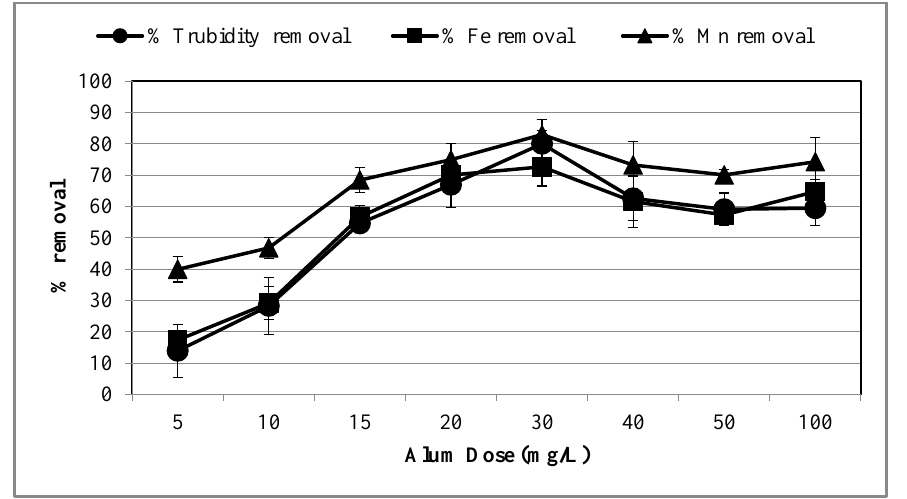
Figure 4. Variation of percent removal of turbidity, total Fe, and total Mn with alum doses. Raw water: turbidity = 1250 NTU, total Fe = 102 mg/L, and total Mn = 12.7 mg/L. Error bar shows the standard deviation of triplicate experiments.